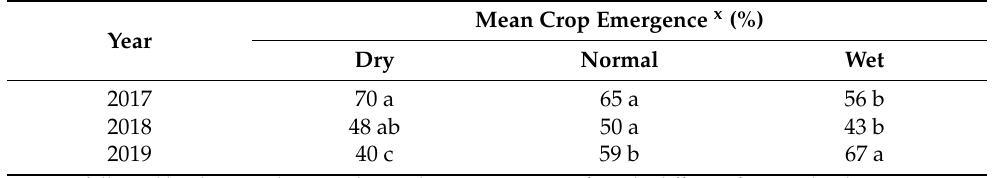
Table 5. Mean crop emergence obtained in different at-plant field conditions in 2017, 2018 and 2019. Mean Crop Emergence x Year